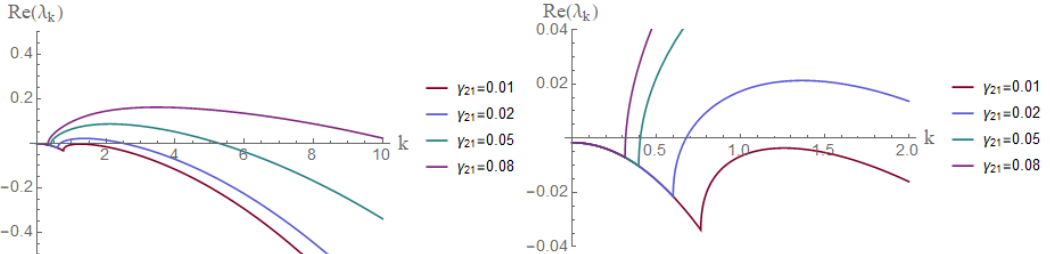
Figure 5. In the left panel , plots of the real part of the eigenvalue λ k defined in (13) as a function of the wavenumber k for different values of the bifurcation parameter γ 21 ; in the right panel , a detail of the same plots. Here again α = 2.5, r = 0.18, γ 11 = 0.01, γ 22 = 0.1, γ 12 = 0.01 and other parameter values as in Table